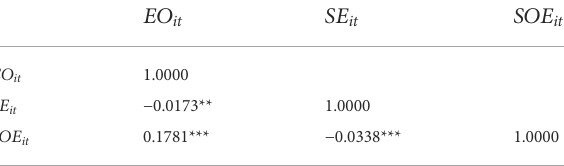
TABLE 2 Correlation matrix of main variables.